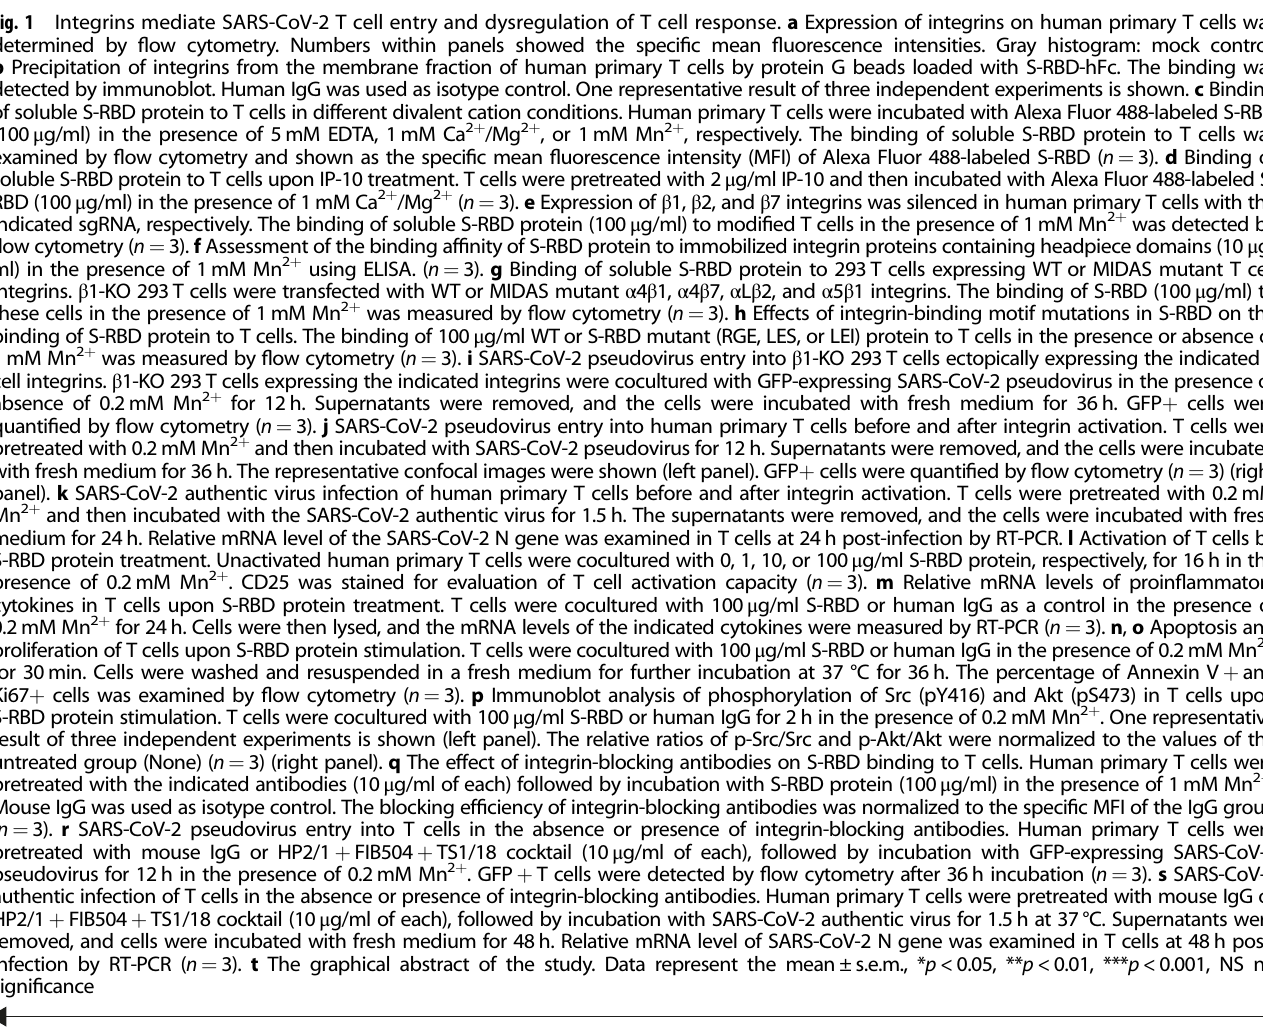
Fig. 1 Integrins mediate SARS-CoV-2 T cell entry and dysregulation of T cell response. a Expression of integrins on human primary T cells was determined by fl ow cytometry. Numbers within panels showed the speci fi c mean fl uorescence intensities. Gray histogram: mock control. b Precipitation of integrins from the membrane fraction of human primary T cells by protein G beads loaded with S-RBD-hFc. The binding was detected by immunoblot. Human IgG was used as isotype control. One representative result of three independent experiments is shown. c Binding of soluble S-RBD protein to T cells in different divalent cation conditions. Human primary T cells were incubated with Alexa Fluor 488-labeled S-RBD (100 μ g/ml) in the presence of 5mM EDTA, 1mM Ca 2 + /Mg 2 + , or 1mM Mn 2 + , respectively. The binding of soluble S-RBD protein to T cells was examined by fl ow cytometry and shown as the speci fi c mean fl uorescence intensity (MFI) of Alexa Fluor 488-labeled S-RBD ( n = 3). d Binding of soluble S-RBD protein to T cells upon IP-10 treatment. T cells were pretreated with 2 μ g/ml IP-10 and then incubated with Alexa Fluor 488-labeled S- RBD (100 μ g/ml) in the presence of 1mM Ca 2 + /Mg 2 + ( n = 3). e Expression of β 1, β 2, and β 7 integrins was silenced in human primary T cells with the indicated sgRNA, respectively. The binding of soluble S-RBD protein (100 μ g/ml) to modi fi ed T cells in the presence of 1mM Mn 2 + was detected by fl ow cytometry ( n = 3). f Assessment of the binding af fi nity of S-RBD protein to immobilized integrin proteins containing headpiece domains (10 μ g/ ml) in the presence of 1mM Mn 2 + using ELISA. ( n = 3). g Binding of soluble S-RBD protein to 293 T cells expressing WT or MIDAS mutant T cell integrins. β 1-KO 293T cells were transfected with WT or MIDAS mutant α 4 β 1, α 4 β 7, α L β 2, and α 5 β 1 integrins. The binding of S-RBD (100 μ g/ml) to these cells in the presence of 1 mM Mn 2 + was measured by fl ow cytometry ( n = 3). h Effects of integrin-binding motif mutations in S-RBD on the binding of S-RBD protein to T cells. The binding of 100 μ g/ml WT or S-RBD mutant (RGE, LES, or LEI) protein to T cells in the presence or absence of 1mM Mn 2 + was measured by fl ow cytometry ( n = 3). i SARS-CoV-2 pseudovirus entry into β 1-KO 293 T cells ectopically expressing the indicated T cell integrins. β 1-KO 293 T cells expressing the indicated integrins were cocultured with GFP-expressing SARS-CoV-2 pseudovirus in the presence or absence of 0.2 mM Mn 2 + for 12 h. Supernatants were removed, and the cells were incubated with fresh medium for 36 h. GFP + cells were quanti fi ed by fl ow cytometry ( n = 3). j SARS-CoV-2 pseudovirus entry into human primary T cells before and after integrin activation. T cells were pretreated with 0.2 mM Mn 2 + and then incubated with SARS-CoV-2 pseudovirus for 12 h. Supernatants were removed, and the cells were